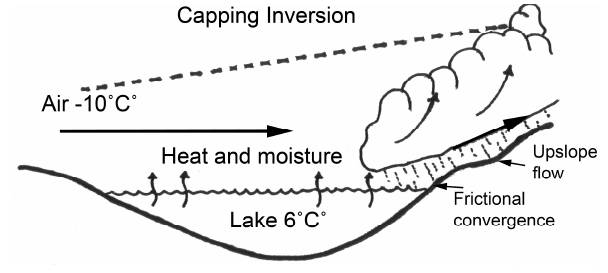
Figure 2. A schematic overview of the important processes driving lake e ff ect